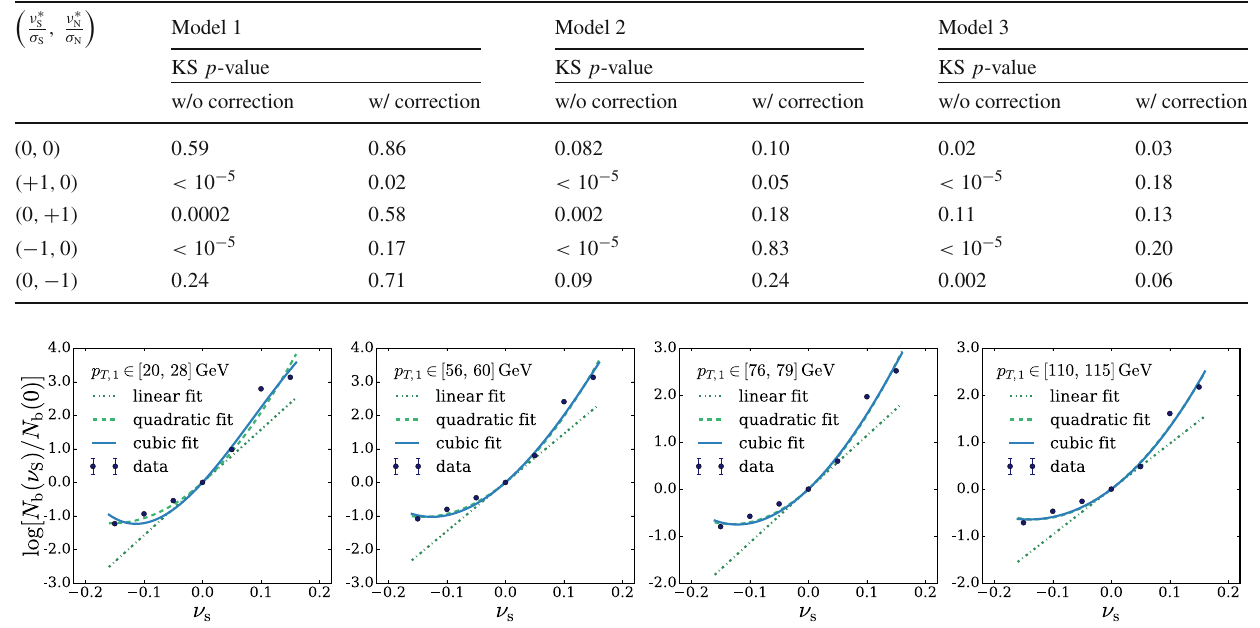
Table 4 Kolmogorov–Smirnov p -value for the compatibility of the τ (“w/o correction” columns) and of the t (“w/ correction” columns) dis- tributionswiththetarget χ 2 distributionformodel1,2,3intheelectron-